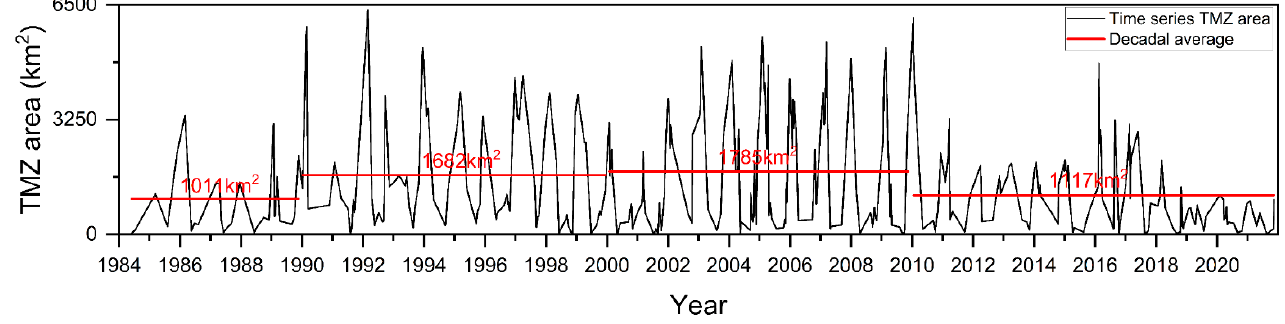
Figure 6. The variation of TMZ area in the Yellow River estuary from 1984 to 2021. Four decadal TMZ averages were calculated, labeled as red numbers above the red line. Four stages cover the